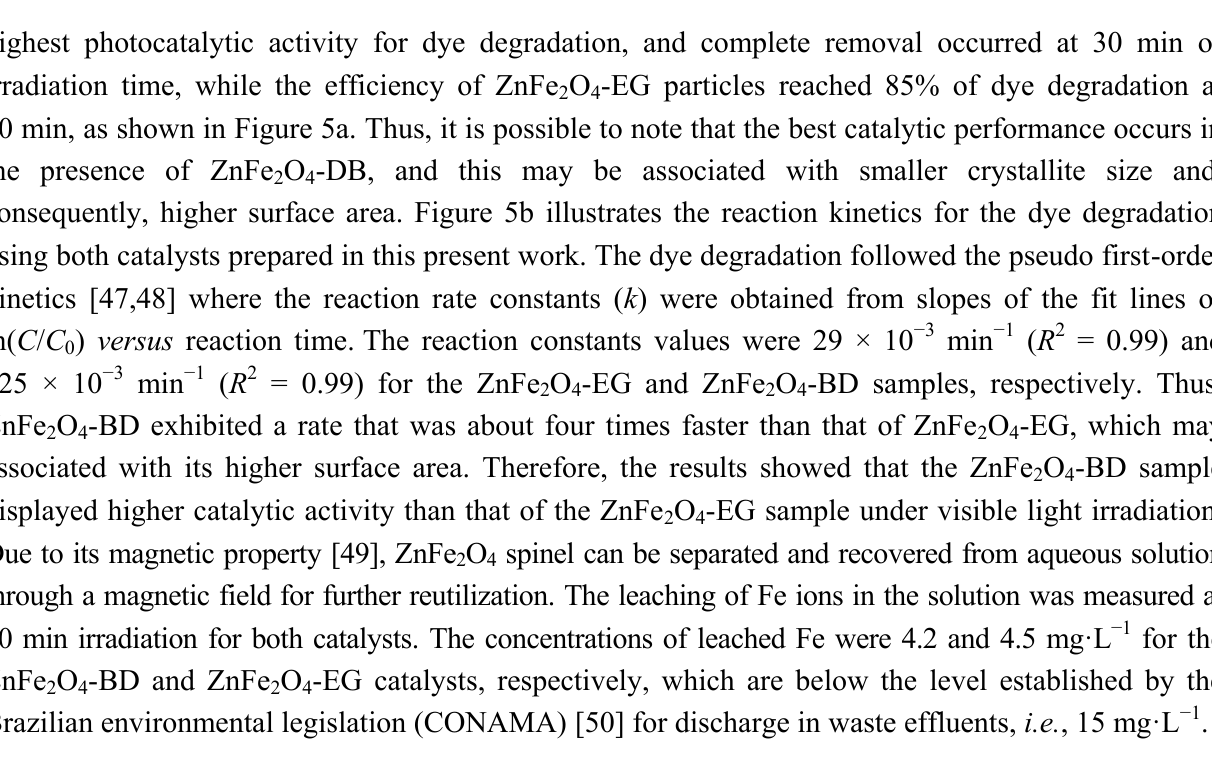
Figure 4. Atomic force microscopy (AFM) of ( a ) ZnFe